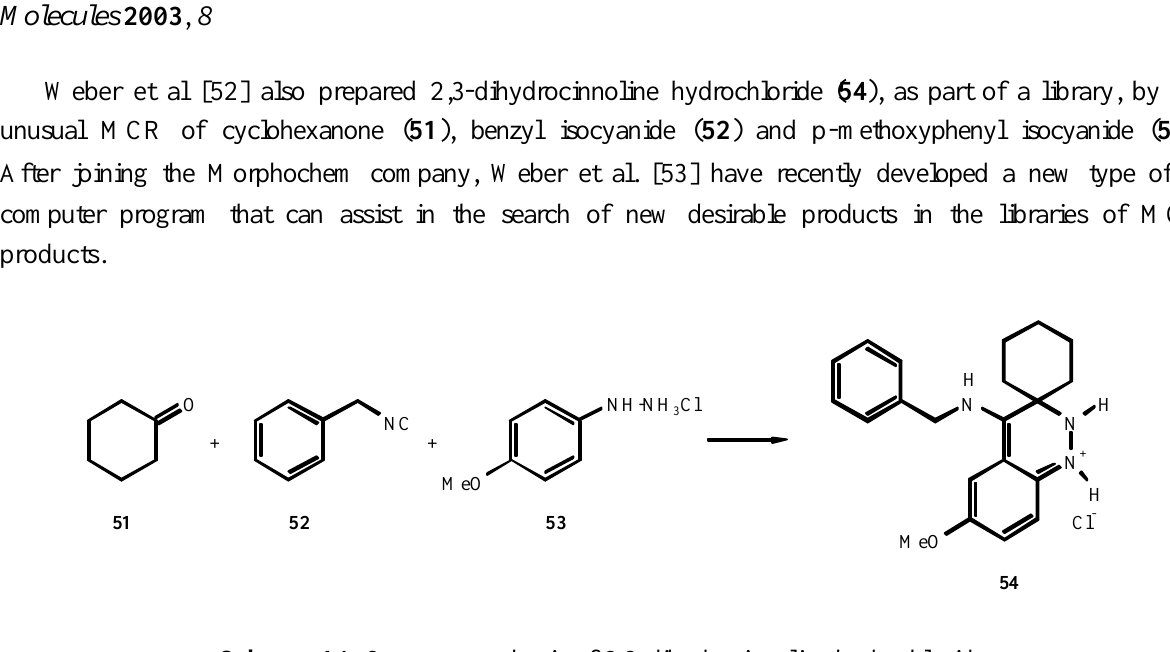
Scheme 14: One-pot synthesis of 2,3-dihydrocinnoline